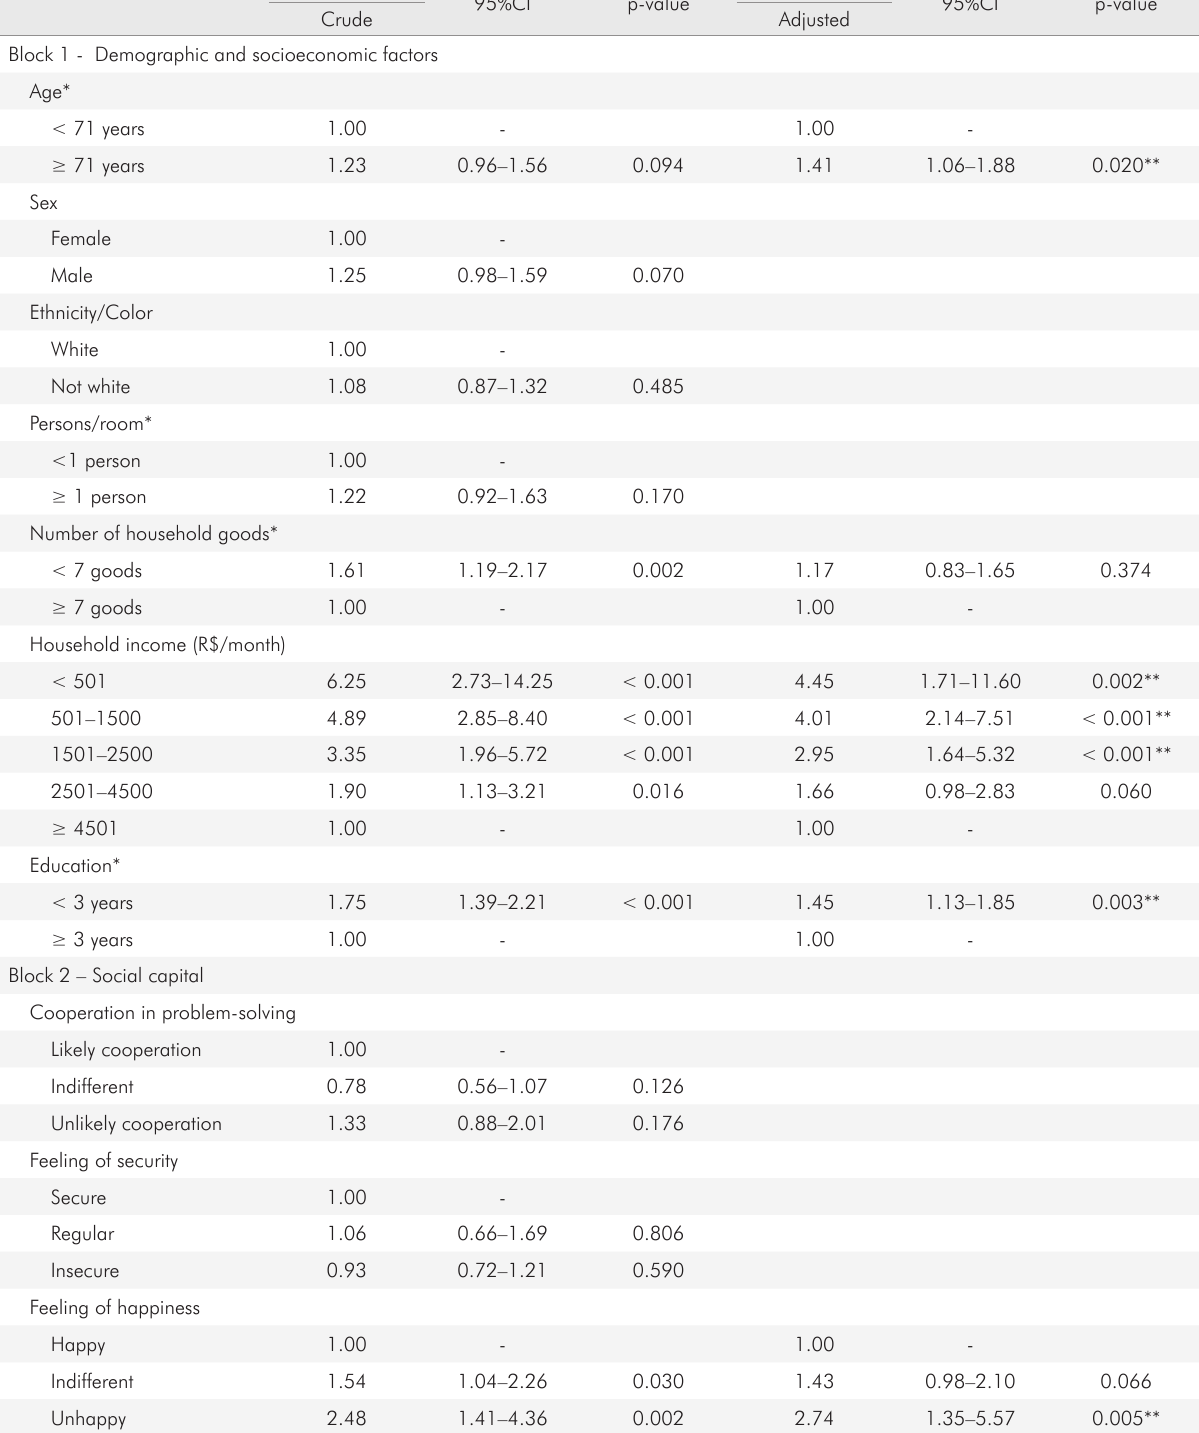
Table 2. Crude and adjusted analysis of the model of multinomial logistic regression for need for complete denture in one arch among elderly residents in State of São Paulo, Brazil, 2015 (n = 5,948).